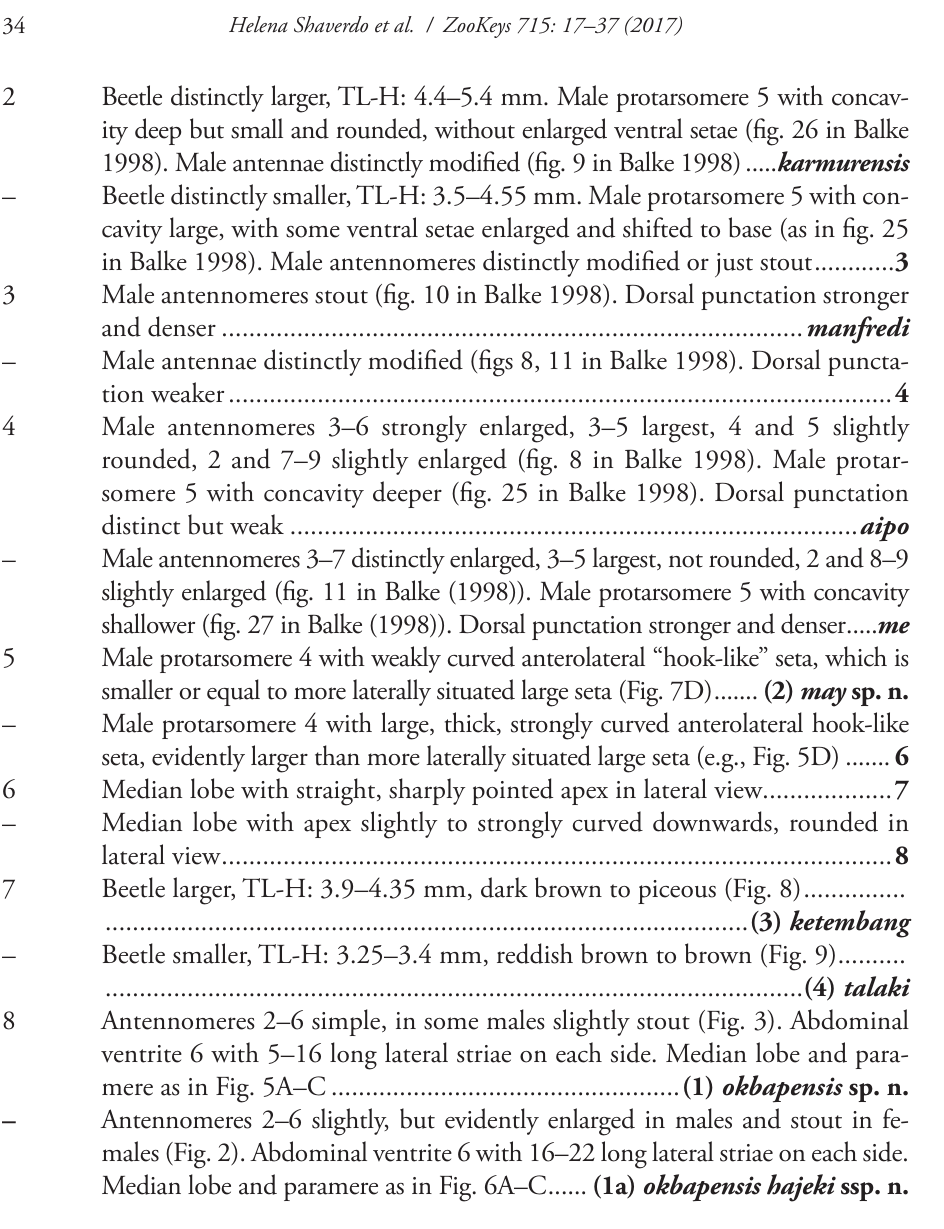
Beetle distinctly larger, TL-H: 4.4–5.4 mm. Male protarsomere 5 with concav- ity deep but small and rounded, without enlarged ventral setae (fig. 26 in Balke 1998). Male antennae distinctly modified (fig. 9 in Balke 1998) ..... karmurensis – Beetle distinctly smaller, TL-H: 3.5–4.55 mm. Male protarsomere 5 with con- cavity large, with some ventral setae enlarged and shifted to base (as in fig. 25 in Balke 1998). Male antennomeres distinctly modified or just stout ............ 3 3 Male antennomeres stout (fig. 10 in Balke 1998). Dorsal punctation stronger and denser ..................................................................................... manfredi – Male antennae distinctly modified (figs 8, 11 in Balke 1998). Dorsal puncta- tion weaker ................................................................................................. 4 4 Male antennomeres 3–6 strongly enlarged, 3–5 largest, 4 and 5 slightly rounded, 2 and 7–9 slightly enlarged (fig. 8 in Balke 1998). Male protar- somere 5 with concavity deeper (fig. 25 in Balke 1998). Dorsal punctation distinct but weak ................................................................................... aipo – Male antennomeres 3–7 distinctly enlarged, 3–5 largest, not rounded, 2 and 8–9 slightly enlarged (fig. 11 in Balke (1998)). Male protarsomere 5 with concavity shallower (fig. 27 in Balke (1998)). Dorsal punctation stronger and denser ..... me 5 Male protarsomere 4 with weakly curved anterolateral “hook-like” seta, which is smaller or equal to more laterally situated large seta (Fig. 7D) ....... (2) may sp. n. – Male protarsomere 4 with large, thick, strongly curved anterolateral hook-like seta, evidently larger than more laterally situated large seta (e.g., Fig. 5D) ....... 6 6 Median lobe with straight, sharply pointed apex in lateral view................... 7 – Median lobe with apex slightly to strongly curved downwards, rounded in 7 Beetle larger, TL-H: 3.9–4.35 mm, dark brown to piceous (Fig. 8) ............... – Beetle smaller, TL-H: 3.25–3.4 mm, reddish brown to brown (Fig. 9) .......... 8 Antennomeres 2–6 simple, in some males slightly stout (Fig. 3). Abdominal ventrite 6 with 5–16 long lateral striae on each side. Median lobe and para- mere as in Fig. 5A–C ................................................... (1) okbapensis sp. n. – Antennomeres 2–6 slightly, but evidently enlarged in males and stout in fe- males (Fig. 2). Abdominal ventrite 6 with 16–22 long lateral striae on each side. Median lobe and paramere as in Fig. 6A–C ...... (1a) okbapensis hajeki ssp. n.